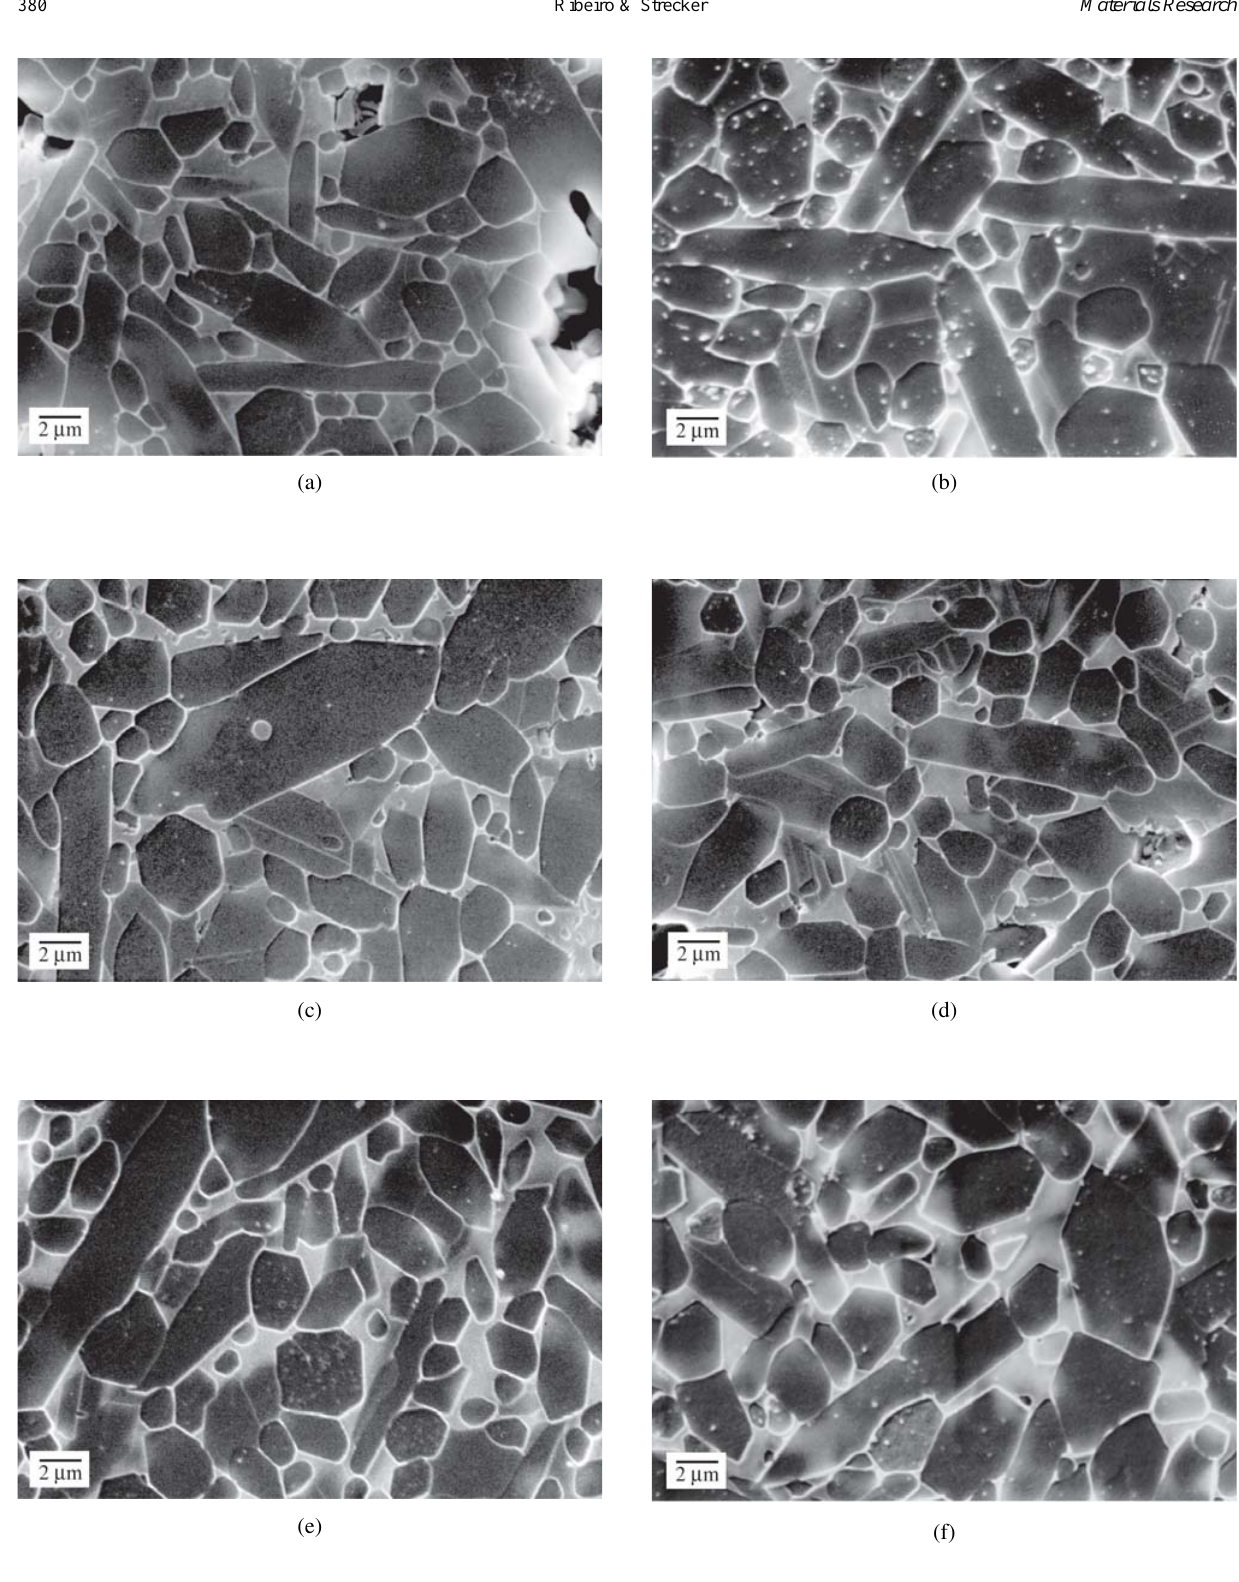
Figure 3. SEM micrographs of sintered SNY14 (a, b and c) and SNTR14 (d, e and f) samples. The samples were sintered at 1800 °C for 30 (a and d), 60 (b and e) and 240 (c and f)